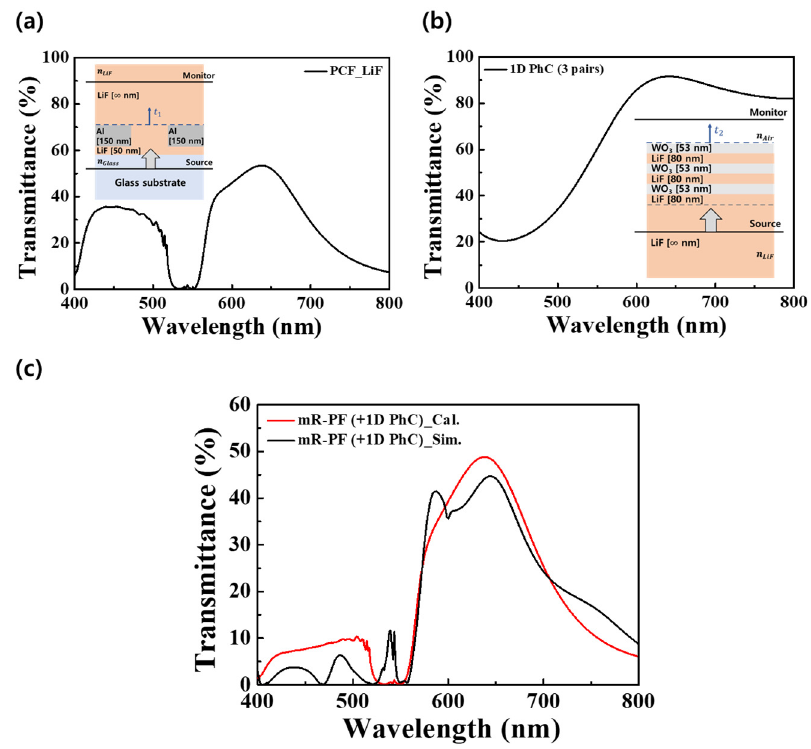
Figure 3. Optical response of mR-PF. Transmission spectra of ( a ) the light transmitted from the glass substrate through to the LiF layer via the PCF structure (inset: schematic of the PCF structure used in the FDTD simulation) and ( b ) the light transmitted from the LiF layer to the air via the 1D PhCs (inset: schematic of the 1D PhC structure used in the FDTD simulation). ( c ) Calculated and simulated transmittance for the mR-PF.